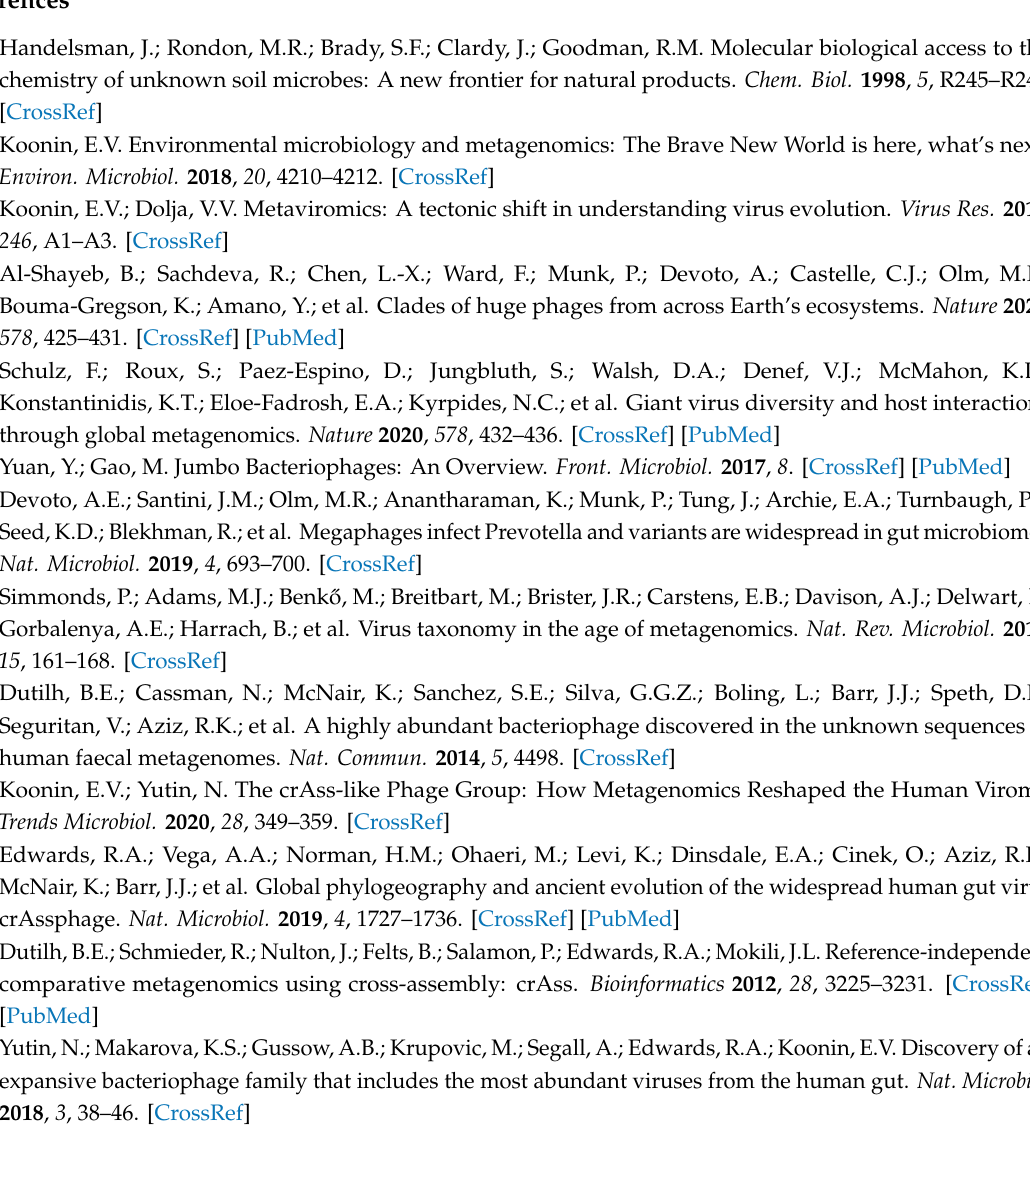
Figure S1: Contig length distribution, Figure S2: Phylogenetic trees of relevant evolutionary events, Figure S3: Distribution of average Shannon information, Figure S4: Distribution of average Pearson coe ffi cients, Table S1: Starting dataset of the project with 805 crAss-like contigs, Table S2: Homologous groups of proteins and corresponding statistics, and Table S3: Results of the 3D function